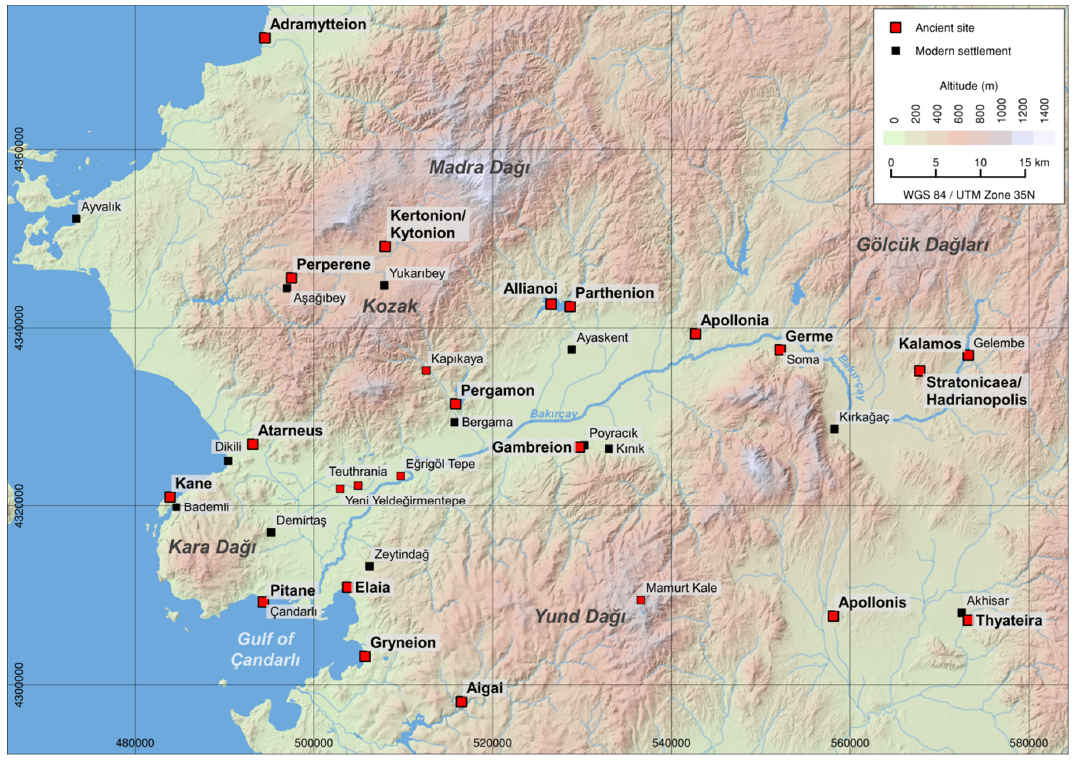
Figure 1. Study area with ancient sites.